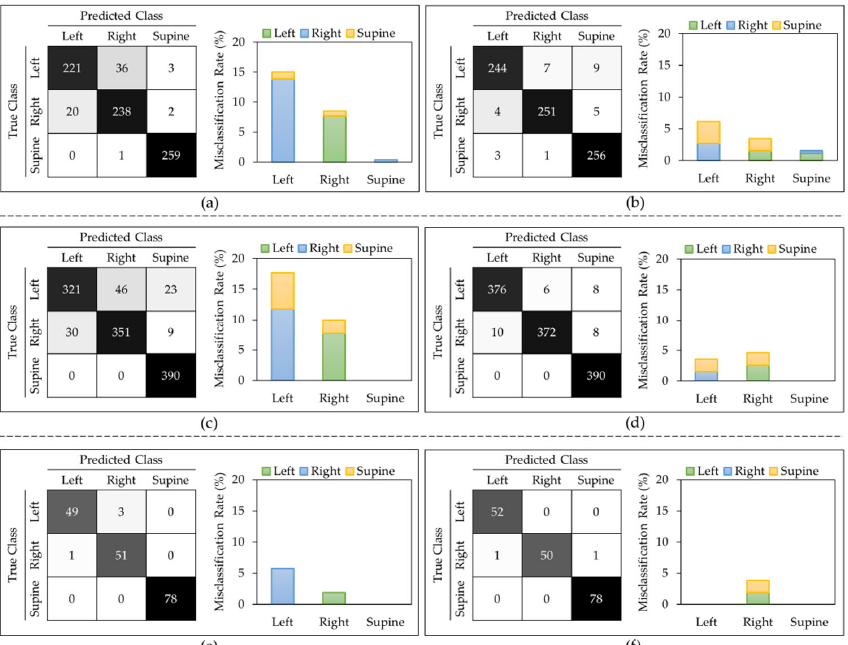
Figure 2. I3D model: Confusion matrix and misclassification rates of all 5 down ‐ sampling runs for ( a ) LOSO and ( b ) 5 ‐ fold. Confusion matrix and misclassification rates of all 5 over ‐ sampling runs for ( c ) LOSO and ( d ) 5 ‐ fold. Confusion matrix and misclassification rates of class weights model for ( e ) LOSO and ( f ) 5 ‐ fold.